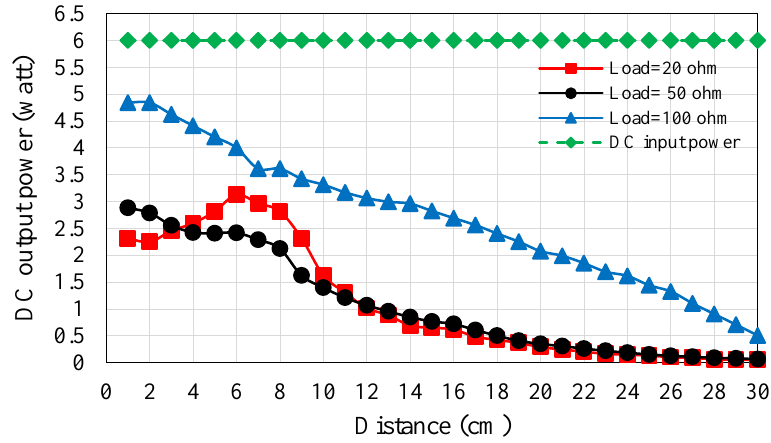
Figure 10. The relationship between output power and transfer distance.